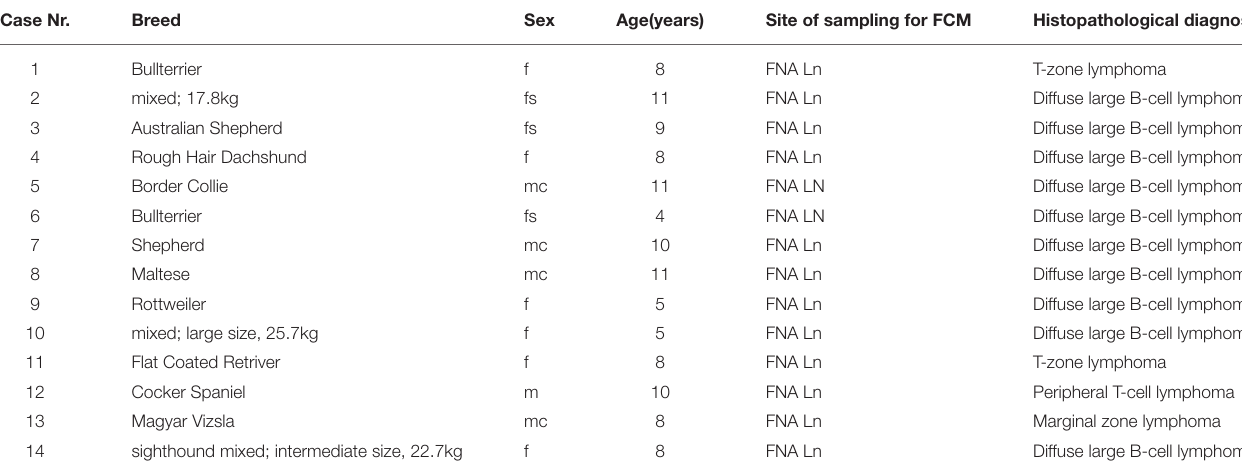
TABLE 3 | Case numbers consecutively used throughout the manuscript (#1 to #14) with breed, sex, age in years, site of sampling for FCM, histopathological diagnosis listed for the 14 lymphoma cases included in the manuscript. Case